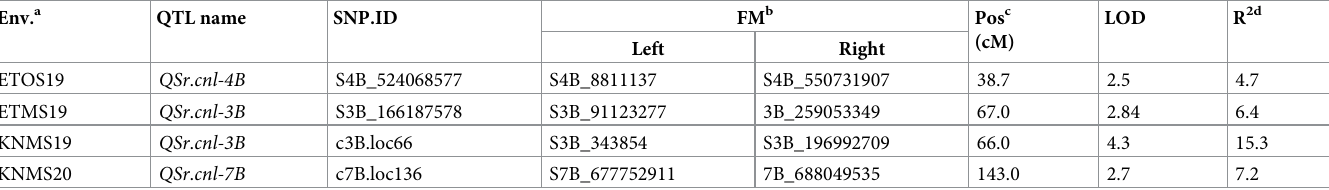
Table 5. QTL identified using composite interval mapping for field response to bulk of Pgt races across four testing environments. Env.